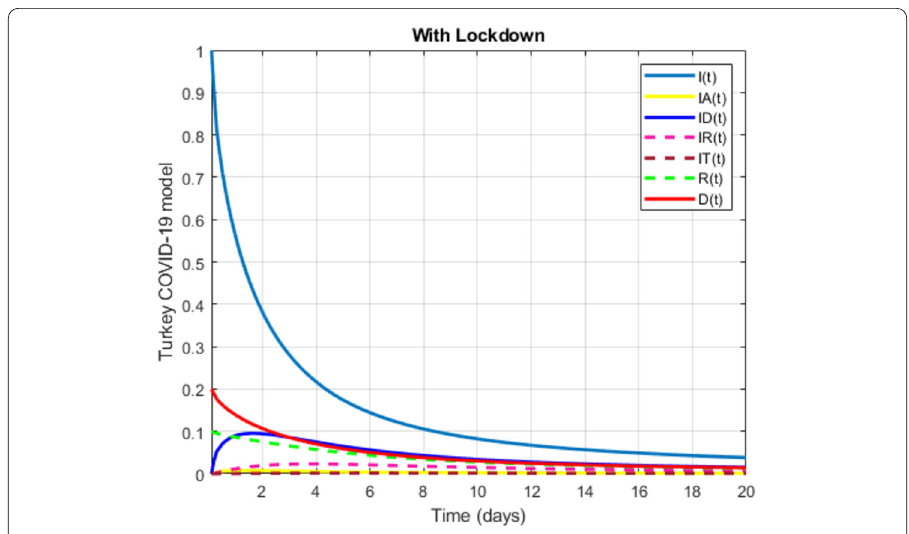
Figure 44 Numerical visualization for Covid-19 model in Turkey for α = 0.7, β =